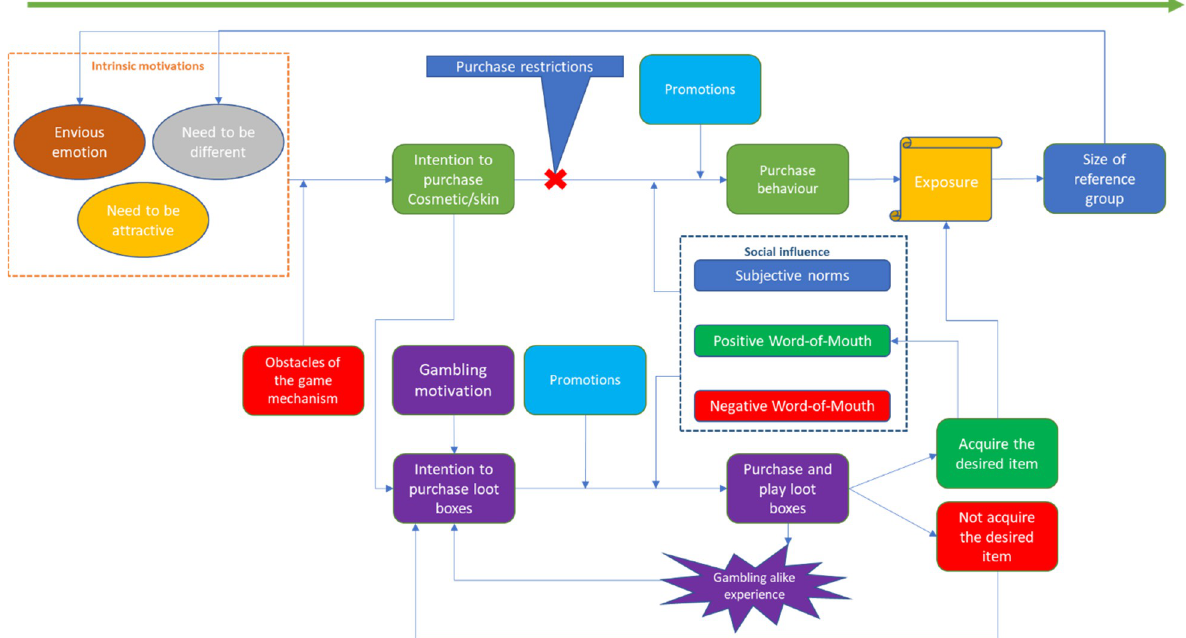
Fig 6. Purchase process of cosmetic/skins, with the existence of loot